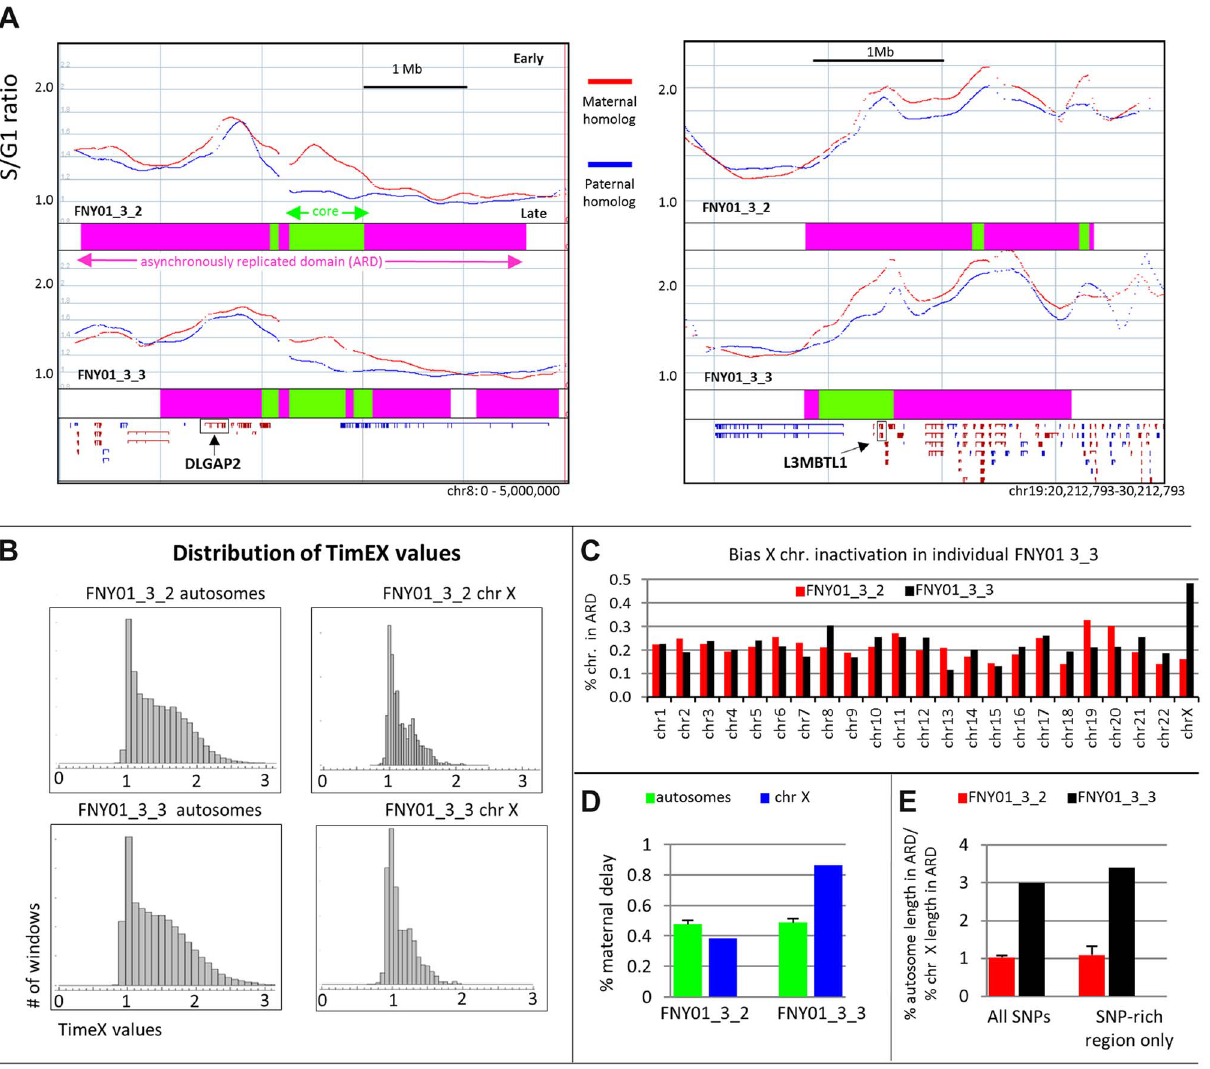
Figure 3. Large asynchronously replicated region contains imprinted genes. A: Plots illustrating two large asynchronously replicating regions containing two paternally imprinted genes DLGAP2 and L3MBTL1 in FNY01_3_2 (top) and 3_3 (bottom). The blue and red curves respectively represent the TimEX profiles of the paternal and maternal homologs (S/G1 copy number ratios after Gaussian smoothing (sigma=100 Kb)). The pink boxes below the curve illustrate the Asynchronously Replicated Domains (ARD); the green boxes, the core ARD. Refseq genes are plotted to indicate the location of the imprinted genes. B: Histogram illustrating the distribution of the TimEX values for the autosomes and the X chromosomes. As expected, the distribution of the values for the autosomes is broader than for the sex chromosomes because one of the X chromosomes replicates uniformly late. C: Histogram illustrating the fraction of the length of each chromosome that is within an ARD region. This fraction varies between 0.1 and 0.3 for all chromosomes except for the X chromosome of individual FNY01_3_3 which contains ARD for almost half of its length. D: Histogram illustrating the fraction of ARD that exhibited a maternal delay for the autosome and for the sex chromosomes. Paternal and maternal delays are approximately equally distributed in all autosomes and in the X chromosome of FNY01_3_2. By contrast almost 90% of the ARD in chromosome X of FNY01_3_3 exhibit a maternal delay. E: Histogram illustrating the ratios of the percentages of the length of the autosome that is asynchronously replicated to the percentage of the X chromosome that is asynchronously replicated in FNY01_3_2 and 3_3 considering all the SNPs or only the SNPs rich regions. The imbalance in the percent X chromosome that is inactivated of FNY01_3_3 can be detected even when only the SNP-rich regions are taken into consideration. Together Figure 3B to 3E strongly suggest that X inactivation in the erythroid lineage of individual FNY01_3_3 is biased toward the maternal chromosome which is inactivated more often than the paternal